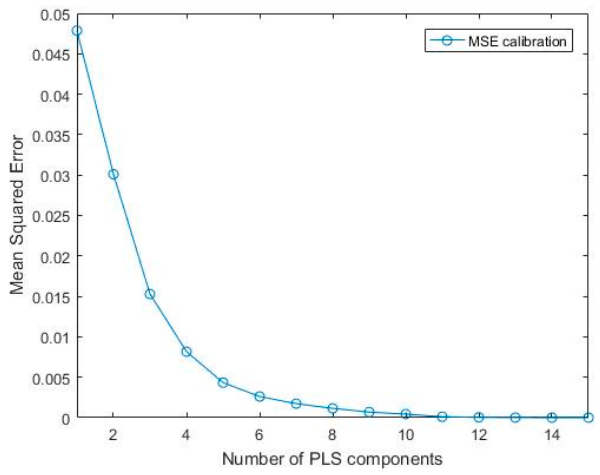
Figure 2. Scree plot for partial least squares (PLS) ‐ based CO 2 loading Raman calibration model.